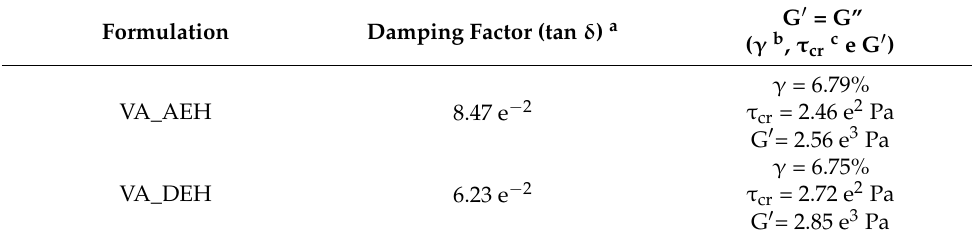
Table 3. Hydrogel cross over point and tan δ